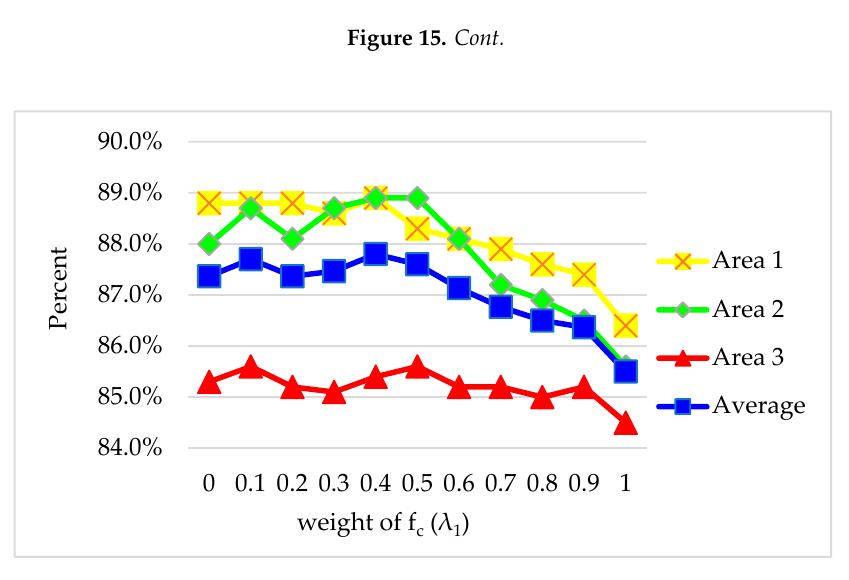
Figure 15. Cont. Remote Sens. 2020 , 12 , x FOR PEER REVIEW